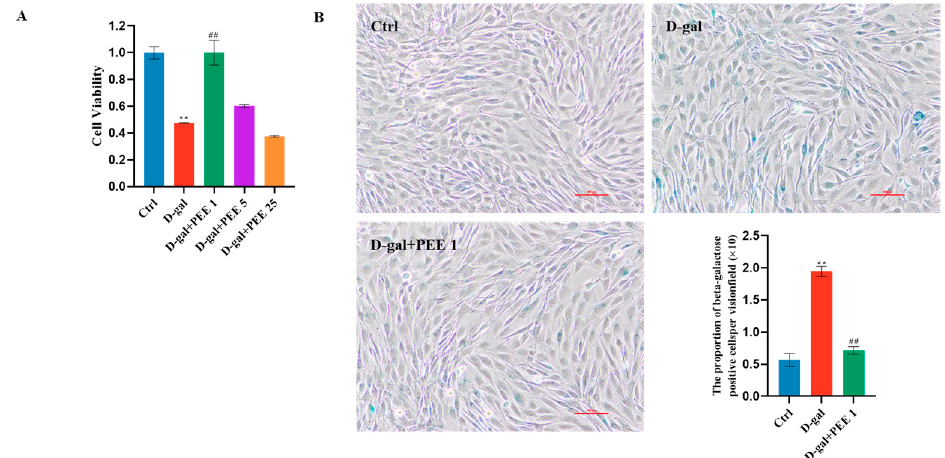
Figure 1. Propolis ethanolic extract (PEE) increased the viability of D-galactose (D-gal)-treated C2C12 cells and attenuated the senescence of C2C12 cells. ( A ) Effect of PEE (1, 5, 25 µ g/mL) on the viability of D-gal-treated C2C12 cells. ( B ) Senescence-associated β -galactosidase (SA- β -Gal) staining and quantification for C2C12 cells (scale bar = 100 µ m). All data are expressed as mean ± SEM (n = 3). ** p < 0.01 vs. Ctrl; ## p < 0.01 vs. D-gal.